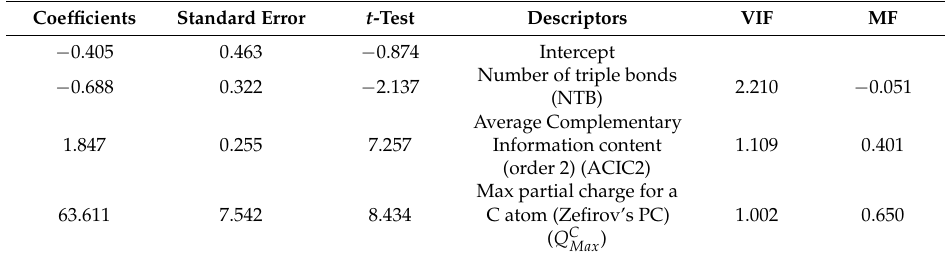
Table 2. Descriptors, Coefficients, Standard Error, and t -Test Values for the Best Multiple Linear Regression (MLR)